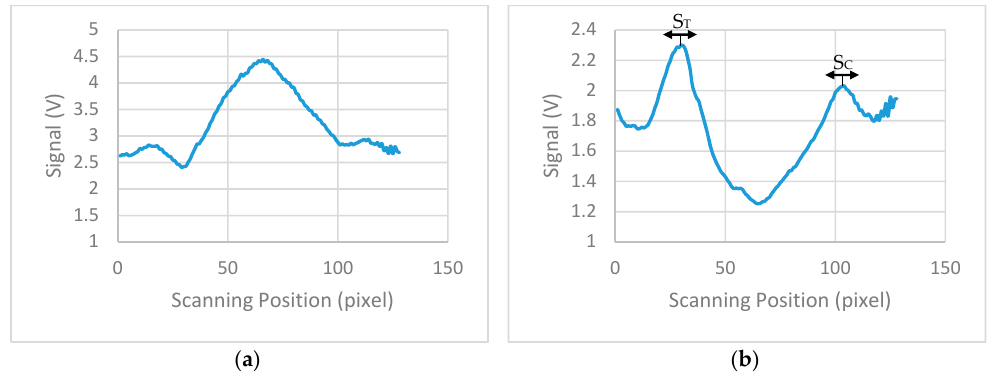
Figure 9. Lateral flow immunoassay with 20 ng/mL concentration of Influenza A nucleoprotein: ( a ) Voltage output of the 8 mm 128 photodiodes chip; ( b ) Voltage output signal after the implementation of background correction using a blank strip showing positions of S T and S C . Table 1. Concentrations of Influenza A nucleoprotein versus the measured signal S T /S C . Concentration of Influenza A Nucleoprotein in (ng/mL) S T /S